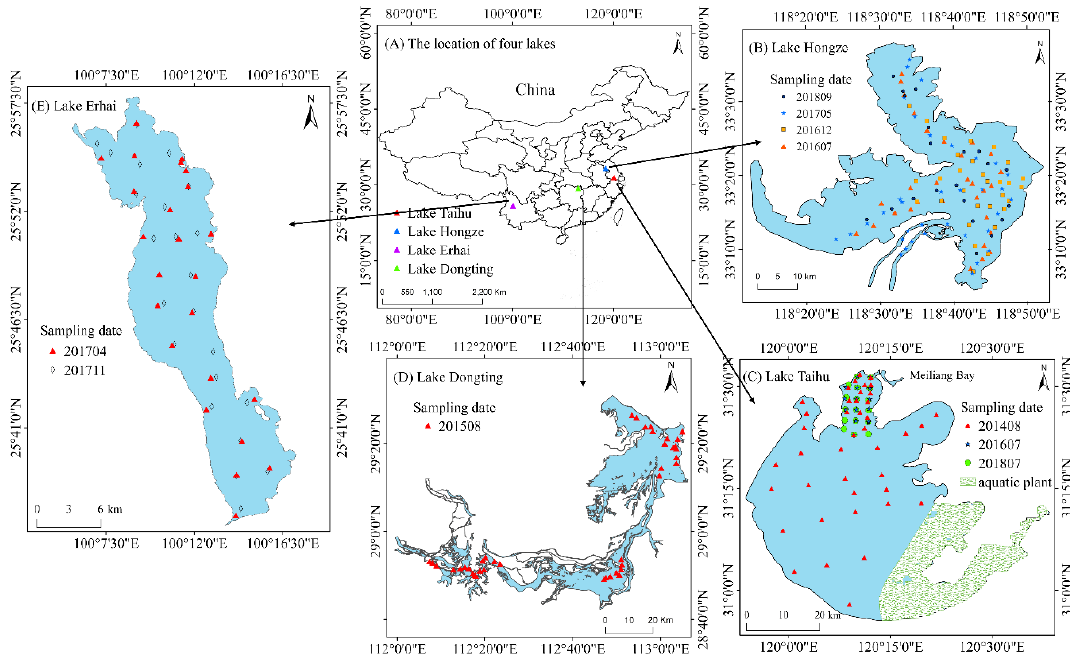
Figure 1. The location of Lake Hongze ( B ), Lake Dongting ( C ), Lake Taihu ( D ), and Lake Erhai ( E ) in China ( A ). The symbols represent the sampling date in year-month forma.